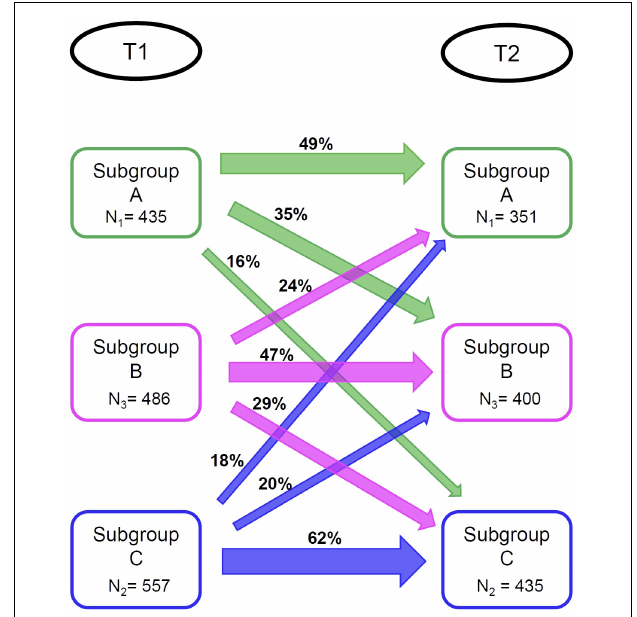
FIGURE 2 | Stability of Subgroup Membership from T1 to